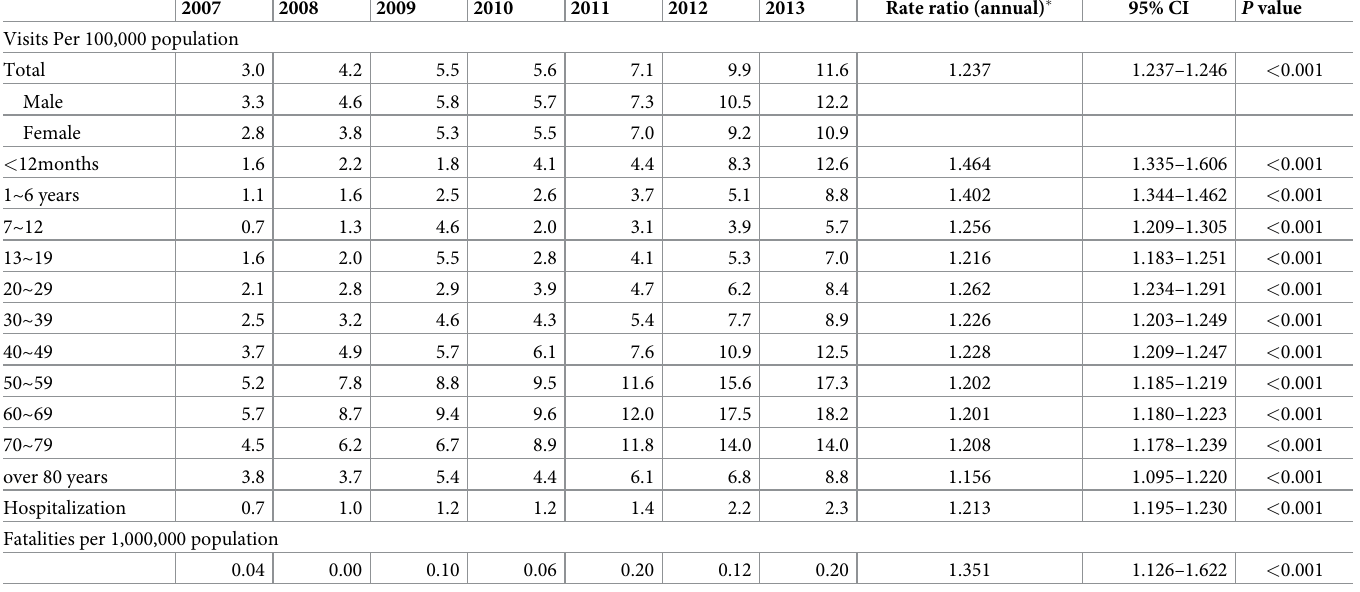
Table 3. Annual incidence rate with anaphylaxis by gender, age-specific group (years) and clinical outcomes.